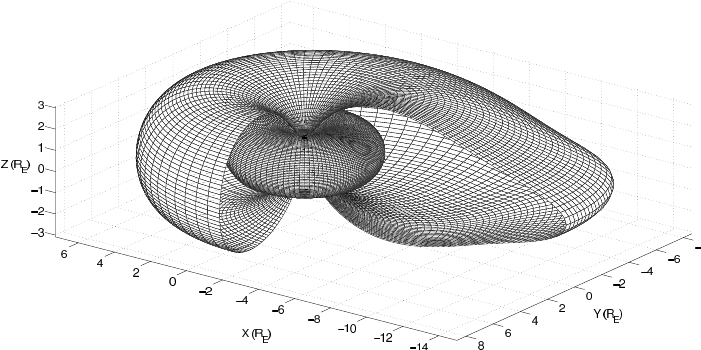
Fig. 1. Inner and outer flux ( ψ ) surfaces enveloping the computational domain (obtained here by field line mapping of quiet-time T01 model). The inner surface, seen through a cut in the outer flux surface, is almost a torus, due to the quasi-axisymmetry in magnetic field so close to Earth (the Earth, not visible in the figure, is at [ X,Y,Z ] = [0,0,0]). The outer surface, however, is highly asymmetric, due to magnetic field stretching in the magnetotail. Constant χ lines (circling in the azimuthal direction) and α lines (also representing the B field lines, since B = ∇ ψ × ∇ α ) are also shown on both flux